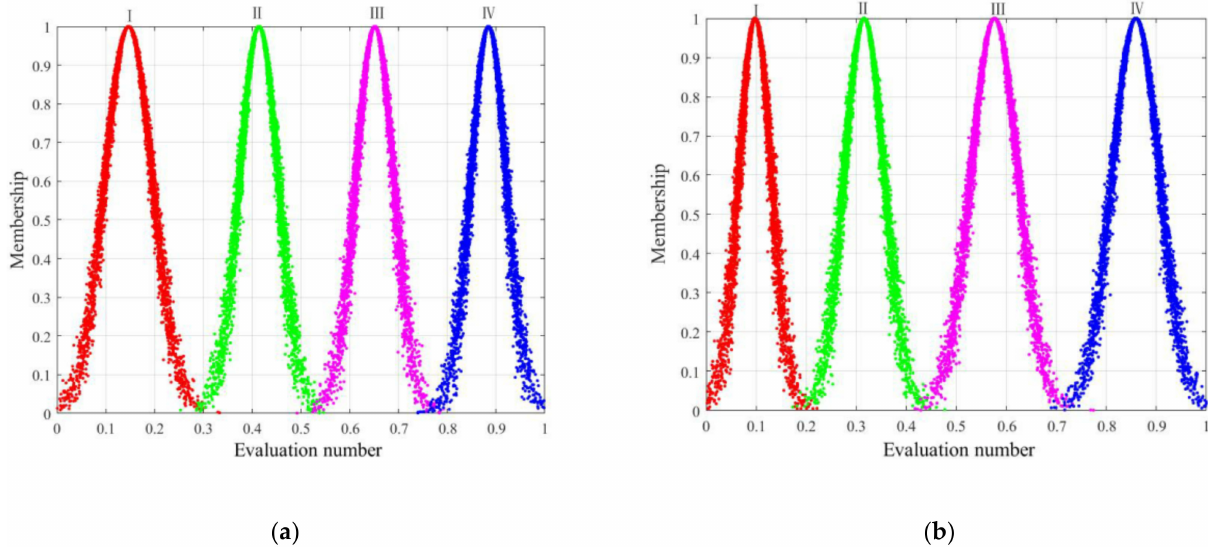
Figure 4. Comprehensive standard cloud model for first-level indicators; ( a ) mining disturbance; ( b ) geological structure.